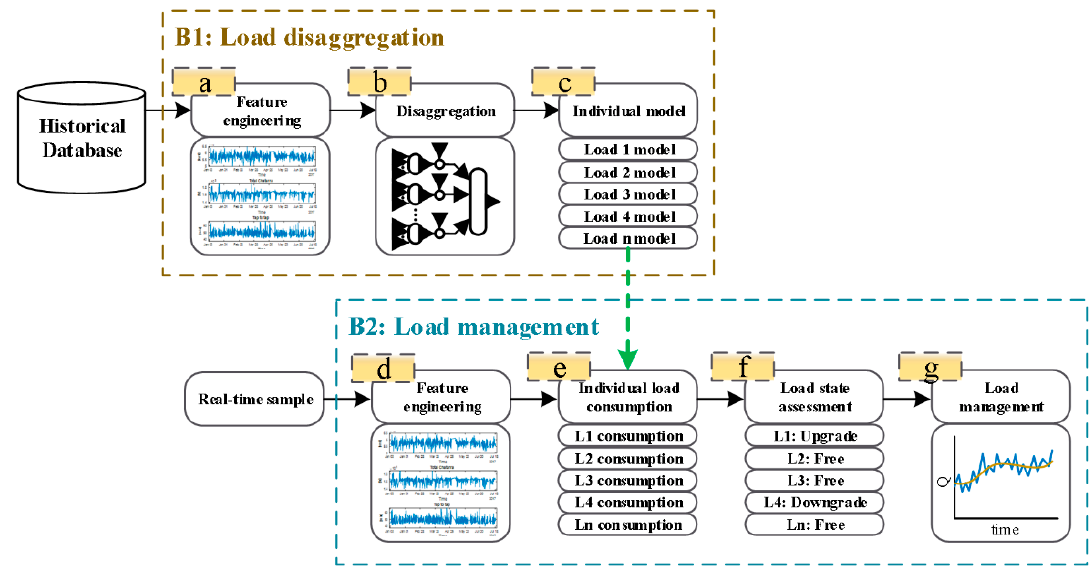
Figure 6. Proposed load management methodology diagram with the two main blocks highlighted.